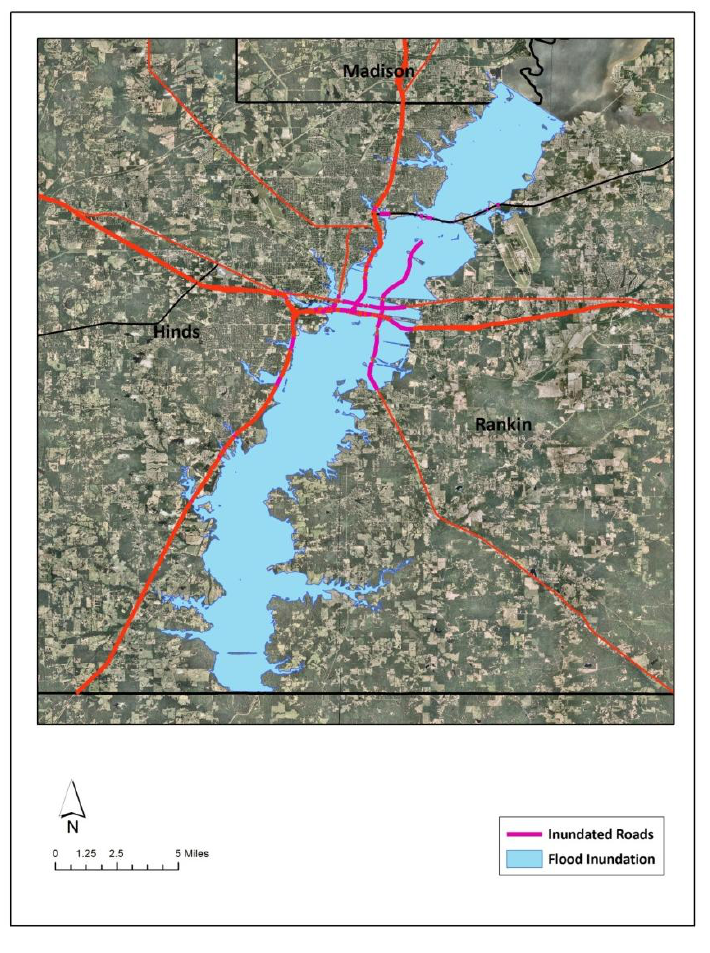
Figure 18. Spatial location of possible disruptions in the major transportation